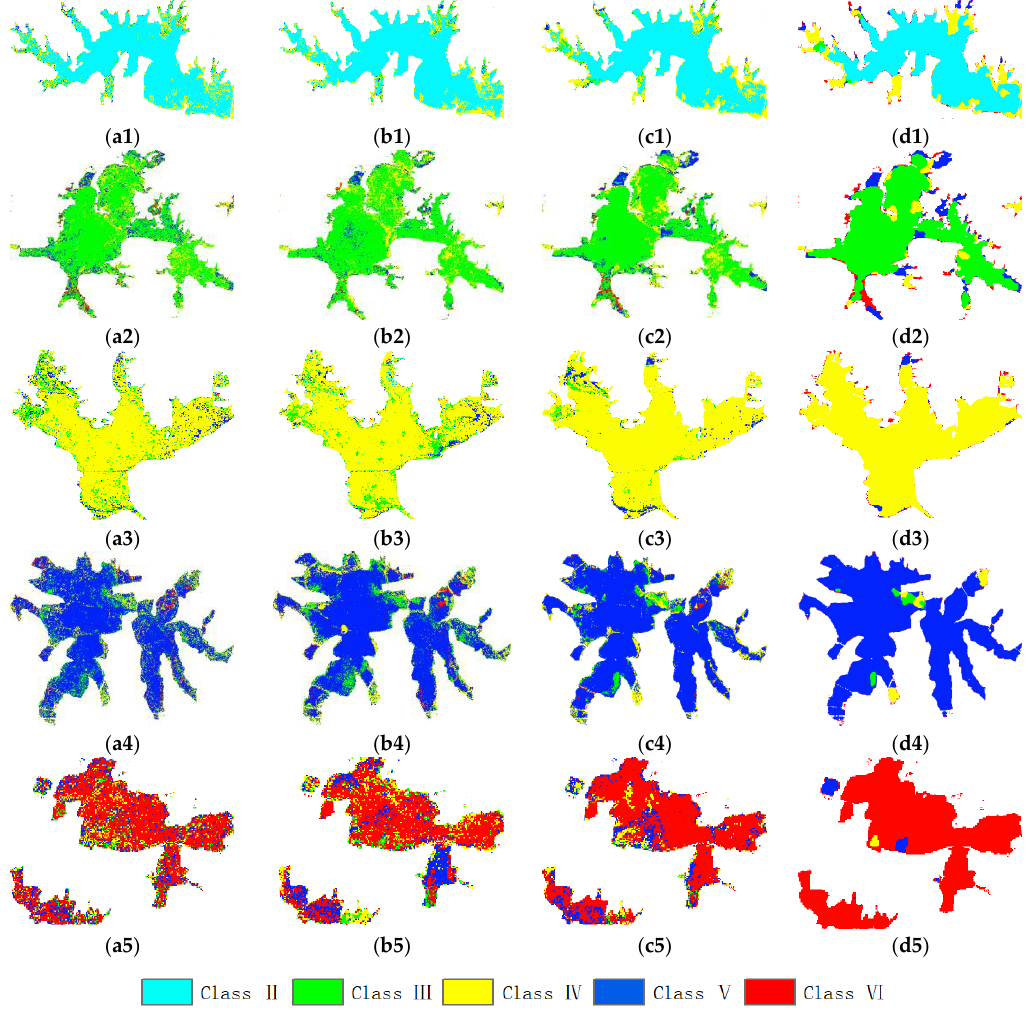
Figure 4. The classification result of the water quality levels of the lakes for the Wuhan dataset: ( a1 – a5